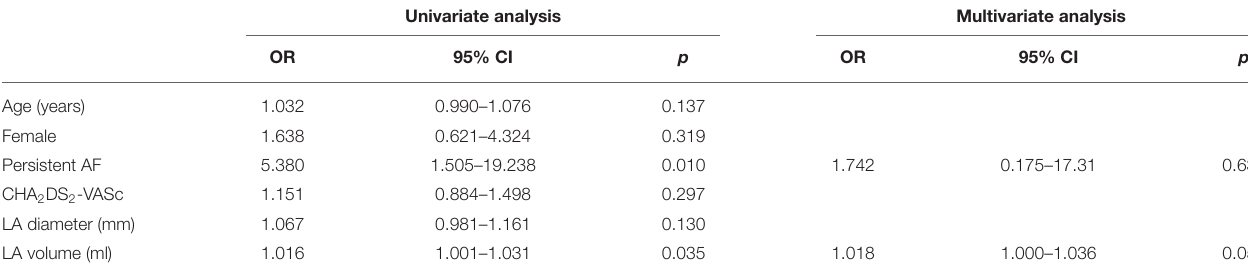
TABLE 3 | Risk factors for the presence of low-voltage zones